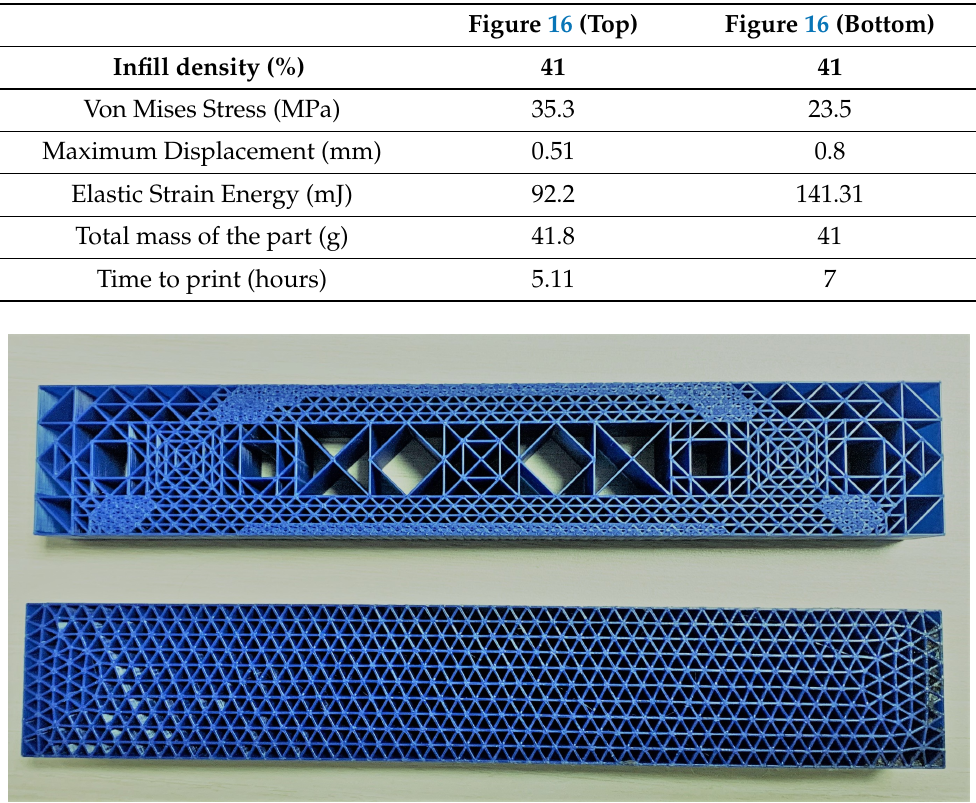
Figure 15. Printed parts with infill density of 41% having optimised infill design ( top ) and uniform infill design ( bottom ).